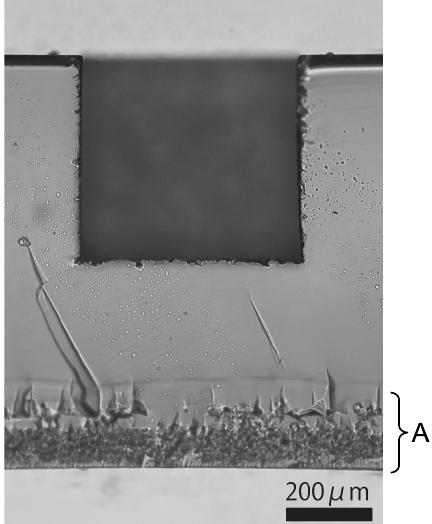
Figure 2. Sectional view of a fabricated hole with square cross-section. “A” indicates the region where laser-induced internal transformation was applied for